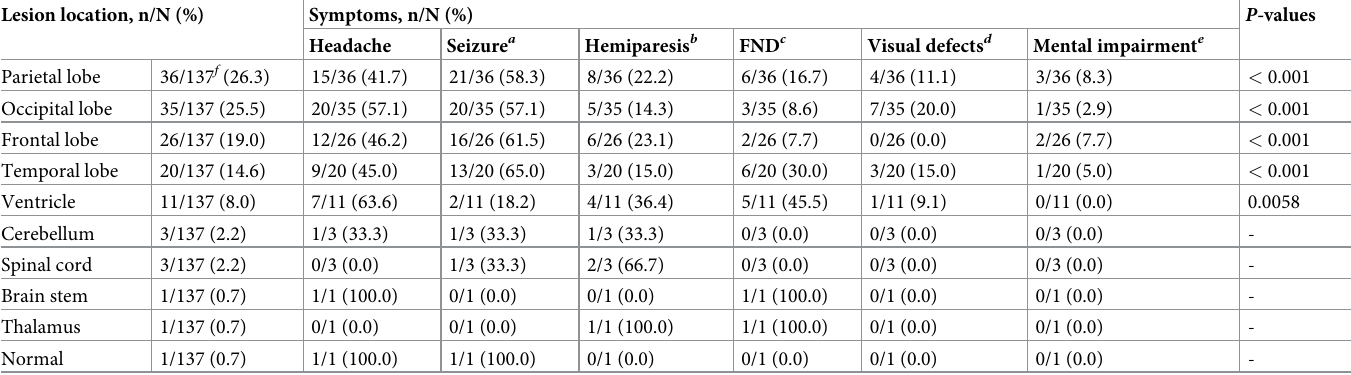
Table 2. Relationship between lesion locations and clinical manifestations of cerebral paragonimiasis patients. Lesion location, n/N